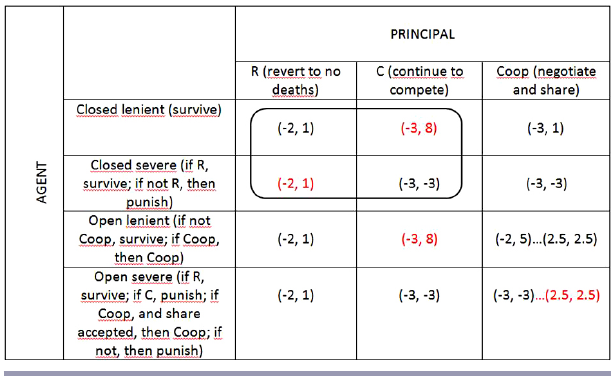
Fig. 3 . Normal form of the dismal game version 1. Maximum payoffs theoretically attainable by the principal and associated agent payoffs. Colored pairs (agent, principal) are Nash equilibria. The four pairs enclosed in a small square are an example of one of the chicken games embedded in version 1.